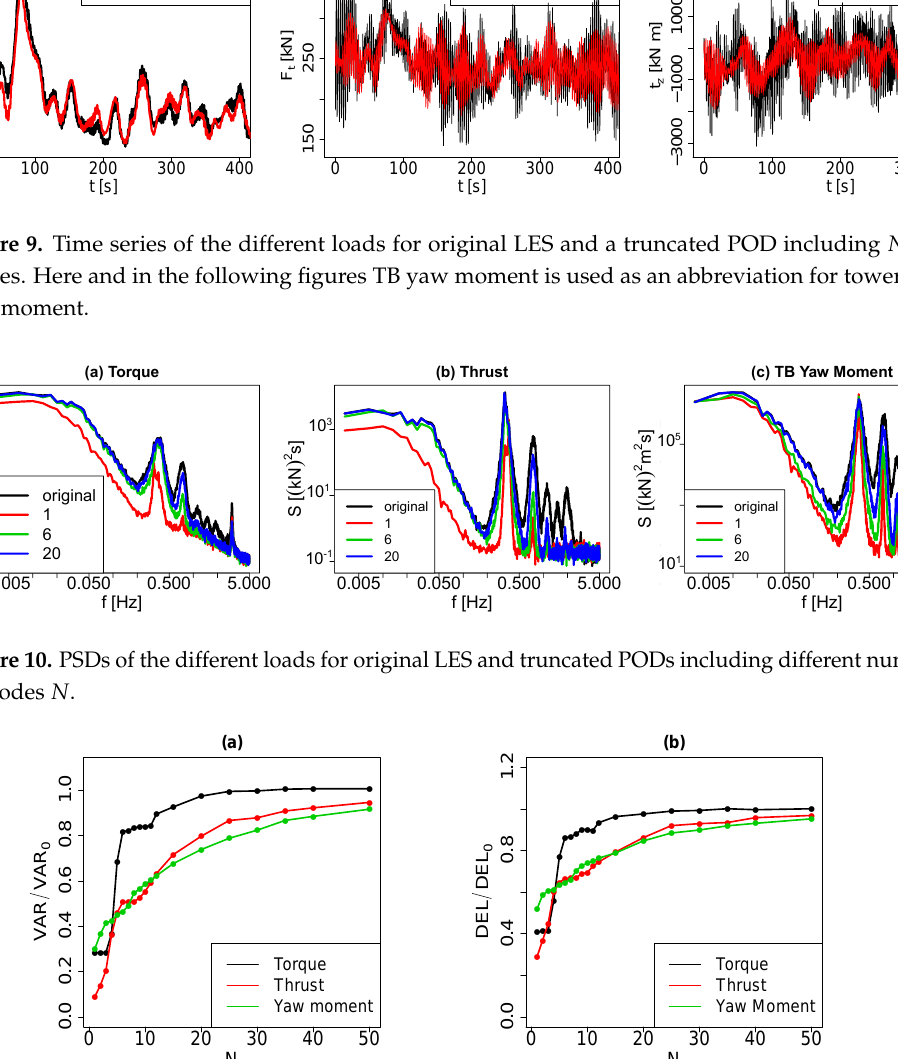
Figure 11. ( a ) Variance and ( b ) damage equivalent loads (DELs) versus the number of modes included in the truncated POD. Both are normalised by the values of the original